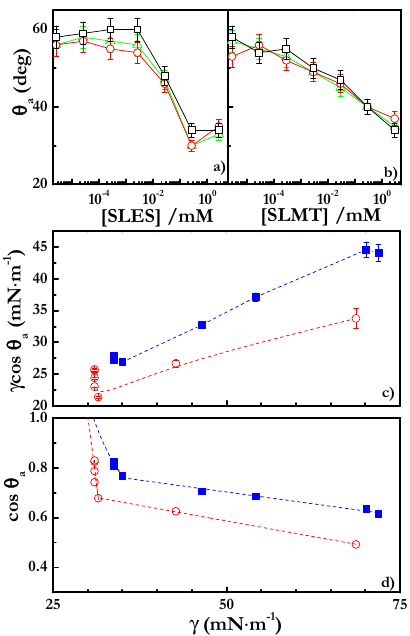
Figure 5. ( a ) Surfactant concentration dependences of the advancing contact angle θ a of sessile droplets of PDADMAC–SLES mixtures with a fixed polymer concentration of 5 g/L on the silicon wafer at three different relative humidities: ( ∆ ) 30%, ( ○ ) 60% and ( □ ) 90%. ( b ) Surfactant concentration dependences of the advancing contact angle θ a of sessile droplets of PDADMAC–SLMT mixtures with a fixed polymer concentration of 5 g/L on the silicon wafer at three different relative humidities: ( ∆ ) 30%, ( ○ ) 60% and ( □ ) 90%. ( c ) Representation γ cos θ a vs. γ for PDADMAC–SLMT ( ■ ) and PDADMAC–SLES ( ○ ) mixtures with a fixed polymer concentration of 5 g/L. ( d ) cos θ a for PDADMAC–SLMT ( ■ ) and PDADMAC–SLES ( ○ ) mixtures with a fixed polymer concentration of 5 g/L on the silicon wafer vs equilibrium liquid/vapor interfacial tension γ . Lines are intended to act as guides.